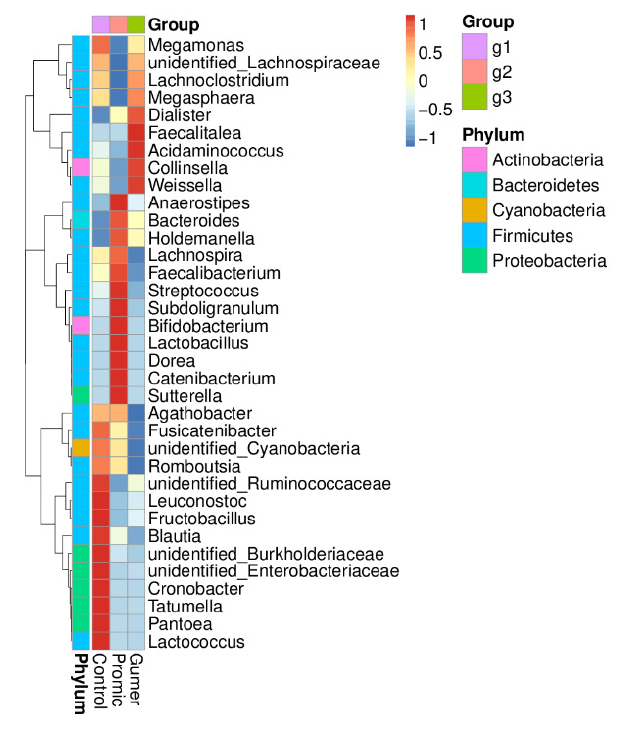
Figure 2. Taxonomic abundance cluster heatmap at the genus level.